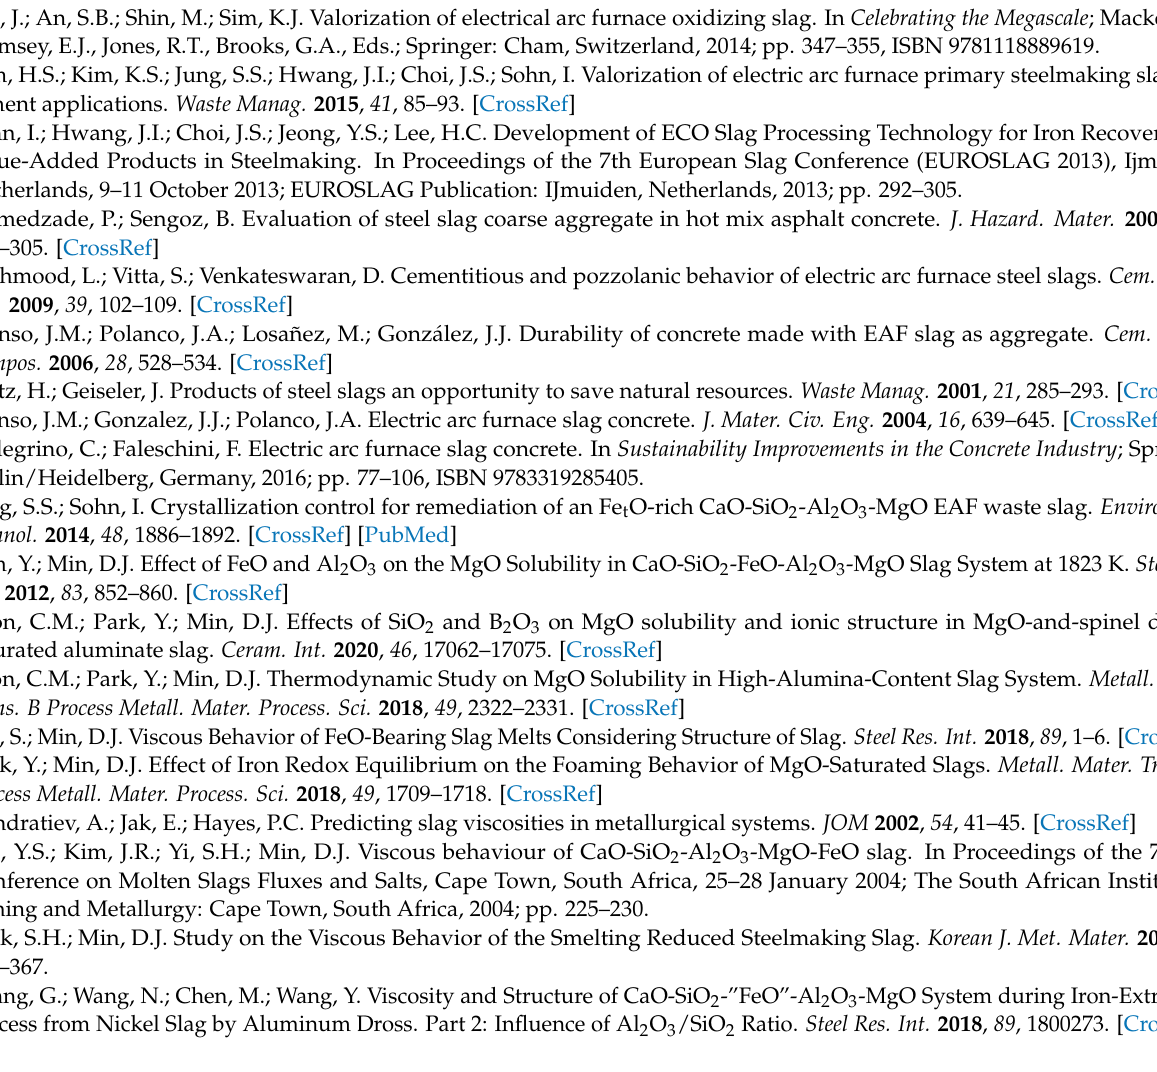
3. According to the intermediate-range order structural investigation by Raman spec- troscopy, the silicate network structure was polymerized with increasing Al 2 O 3 con- centration. Quantitative evaluation of the Q n structural units revealed an increase in Si Q 2 and Q 3 units with a decrease in Q 1 units with increasing Al 2 O 3 concentration, Si Si Si indicating the polymerization of the silicate structure. The association of the [AlO 4 ] tetrahedral units with the [SiO 4 ] tetrahedral silicate network induced the polymeriza- tion of the slag structure and an increase in the viscosity of the molten